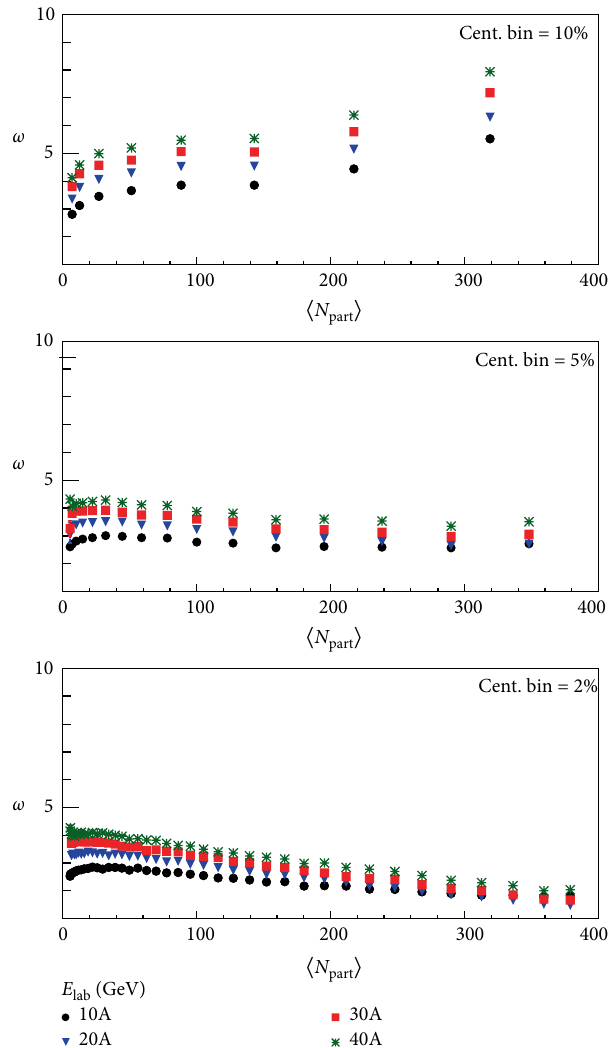
Figure 9: Dependence of scaled variance, 𝜔 on ⟨𝑁 part ⟩ in different centrality-bin